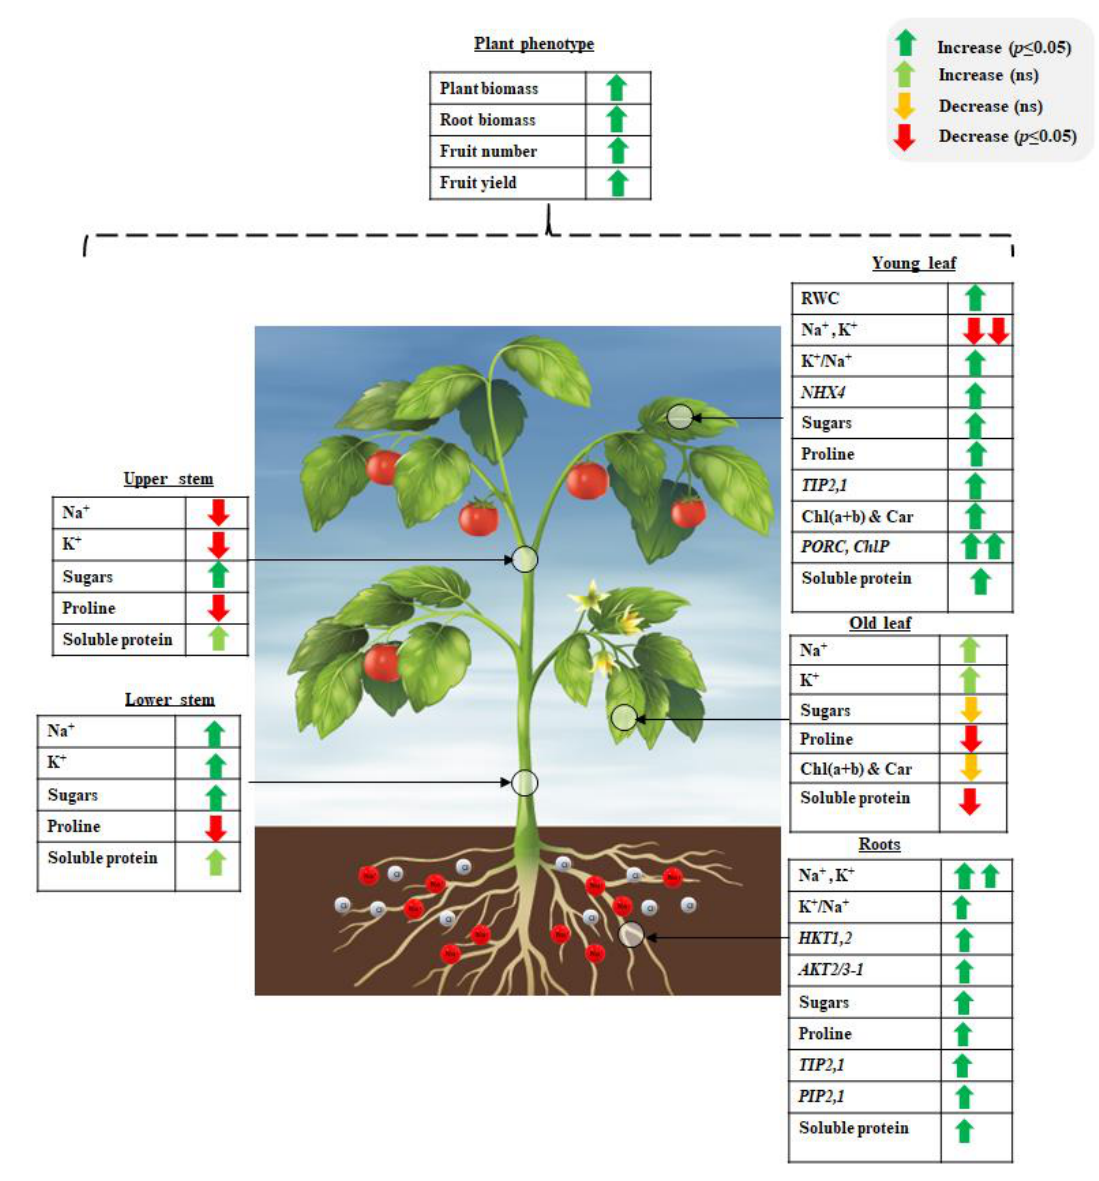
Figure 7. Diagram of PSI-475 mode of action inducing salinity stress tolerance in tomato after 61 days of saline water irrigation. Different parameters at phenotype level (root, plant and fruit) are shown along with physiological, biochemical, and molecular parameters in different plant tissues. Up or down arrow indicate increase of the parameter with respect to that obtained in untreated stressed plants. Different arrow colours indicate the outcome of the statistical hypothesis testing for that change: deep green and deep red imply statistically significant differences according to t -test at p ≤ 0.05, while orange and light green colours show non-significant changes at p ≤ 0.05.